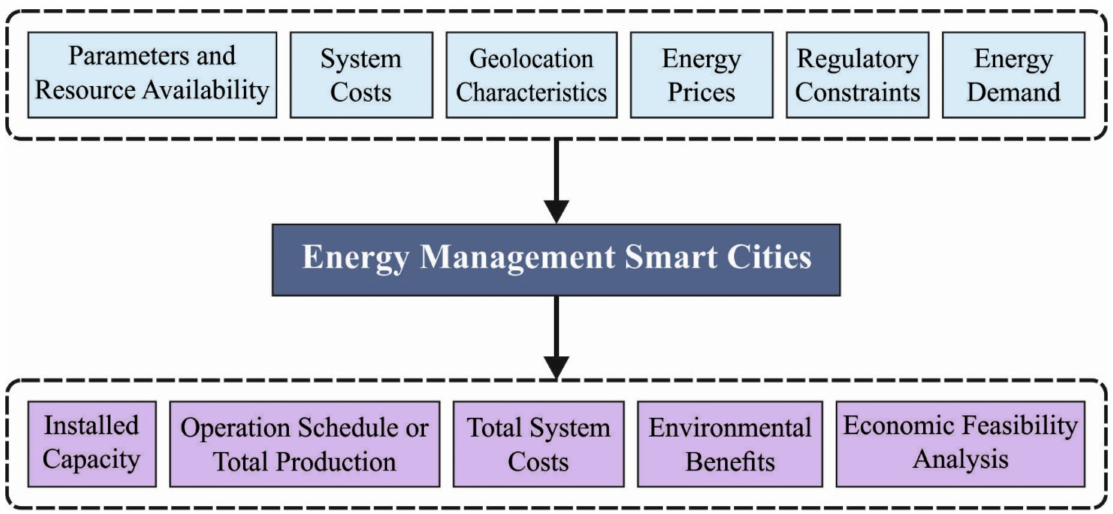
Figure 1. Process of energy management in smart